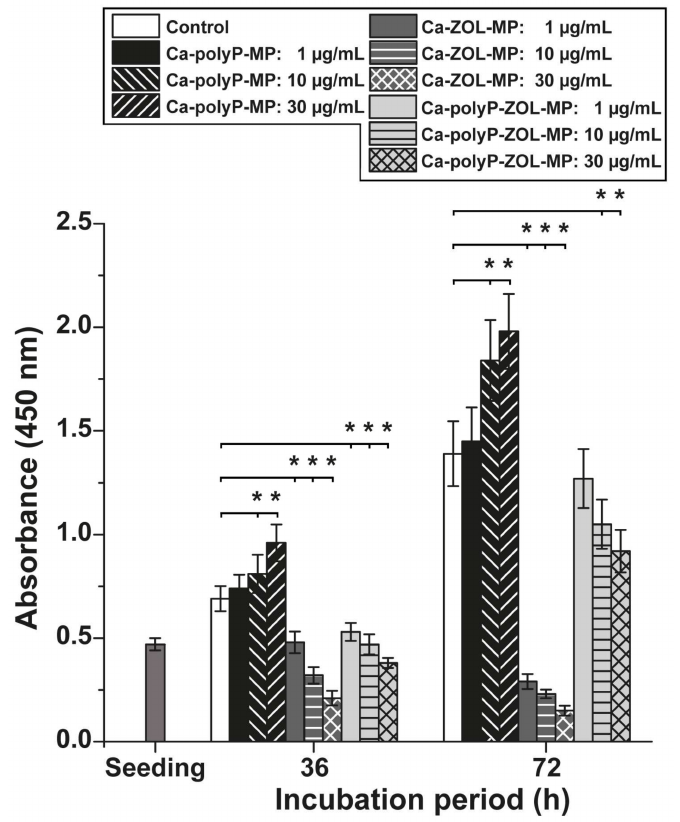
Figure 4. Effect of the different concentrations of particles, either “Ca-polyP-MP”, “Ca-ZOL-MP”, or “Ca-polyP-ZOL-MP” the viability/growth of MSC. The number of viable cells was determined by the XTT assay (A 450 values). The incubation period was 36 h and 72 h, respectively. Ten parallel assays were performed, and the mean values ( ± SD) were determined. The significance correlations are determined with respect to the controls (no particles added); they are marked with rectangular brackets; (* p < 0.001) between the indicated two values. The concentrations of the particles for the respective test samples are given in the